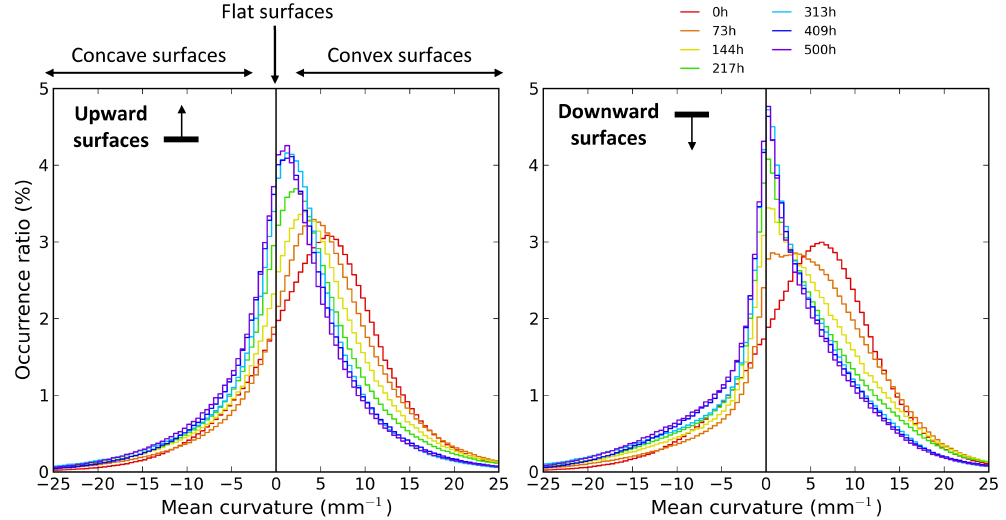
Figure 8. Time evolution of the mean curvature distribution computed from the upward (left panel) and downward (right panel) surfaces of the 3-D images. Each curvature class is 0.5mm − 1 wide.